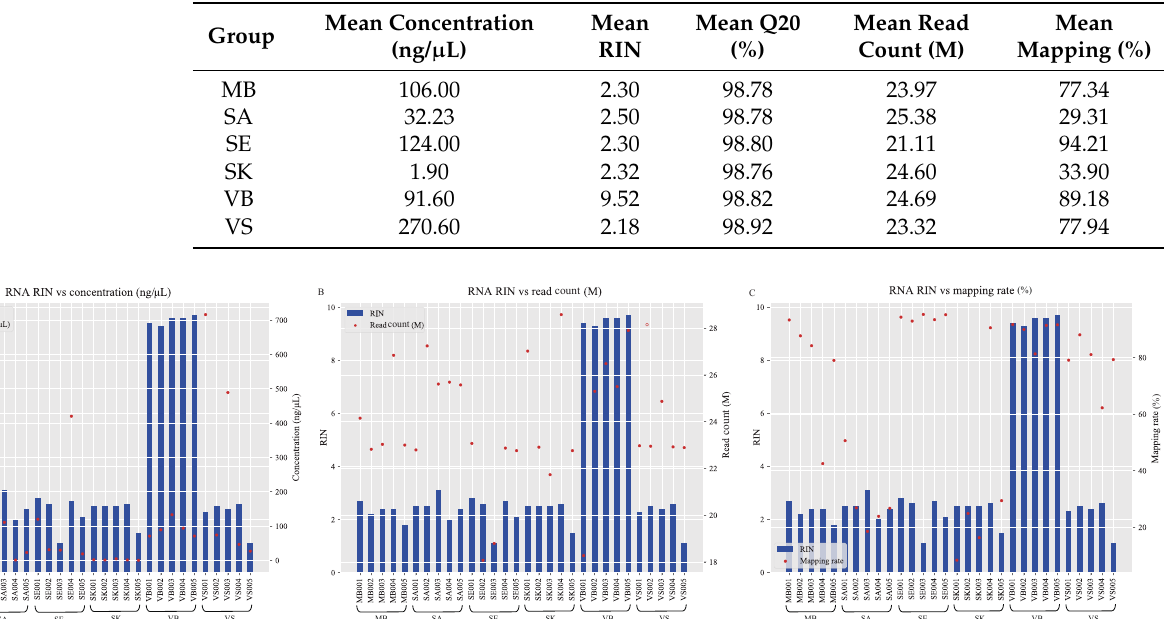
Table 1. The quality and sequencing information of the different groups of samples.